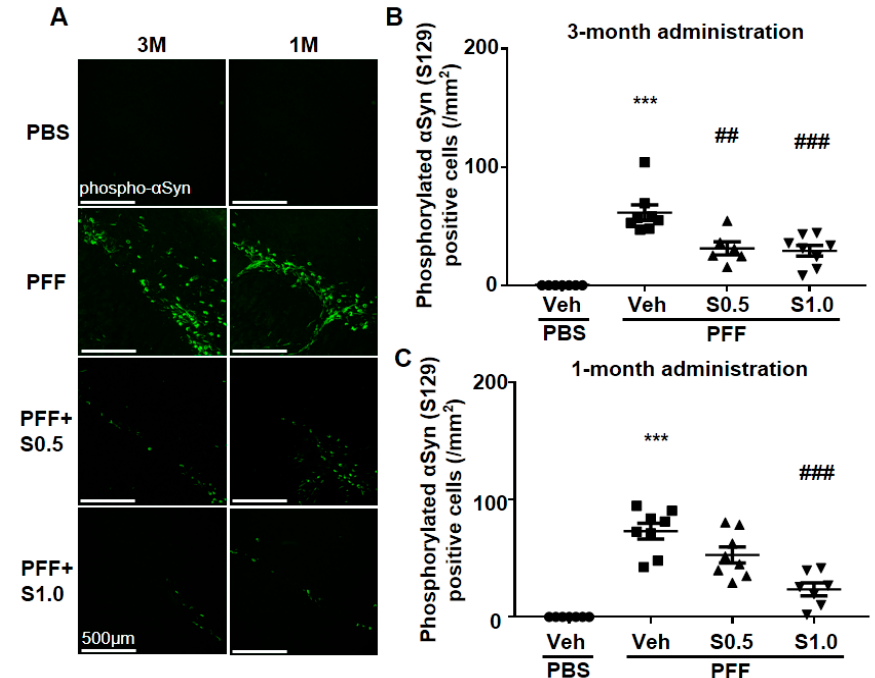
Figure 2. SAK3 chronic administration prevents the spread of phosphorylated α -Syn in PFF-injected mice. ( A ) Repre- sentative immunofluorescence images of phosphorylated α -Syn in the SNc region in both schedules of this study. Scale bar: 500 µ m. The number of phosphorylated α -Syn-positive cells was counted in the SNc region for ( B ) 3 months of the SAK3 treatment schedule ( n = 6–8 per group), and ( C ) 1 month of the SAK3 treatment schedule ( n = 7–8 per group). Error bars represent SEM. *** p < 0.001 vs. vehicle-treated PBS injection mice; ## p < 0.01, ### p < 0.001 vs. vehicle-treated α -Syn PFF-injected mice. Abbreviations: Veh = vehicle; S =